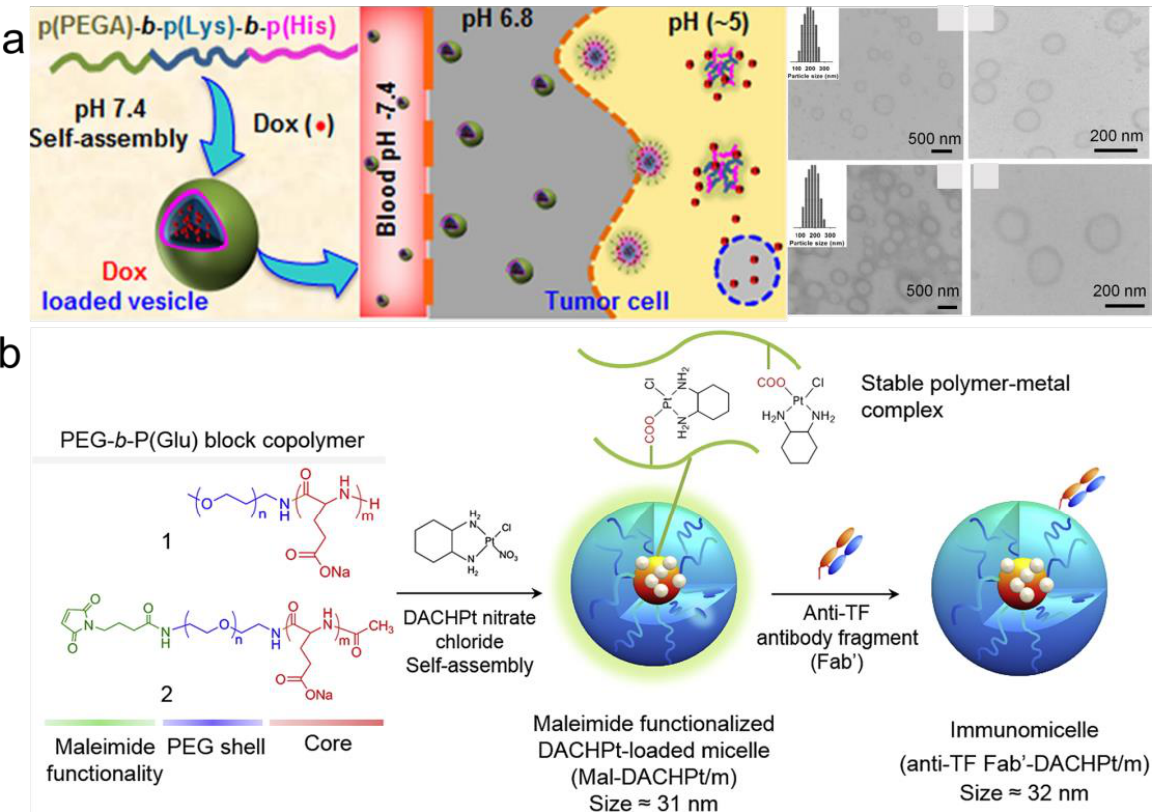
Figure 5. Drug loading in PVs. ( a ) p(PEGA) 30 -b-p(Lys) 25 -b-p(His) n assembled into vesicles with DOX loading. Reprinted with permission from Ref. [74]. Copyright: 2015, American Chemical Society. ( b ) DACHPt loading into PEG-b-PLG copolymers. Reprinted with permission from Ref. [77]. Copyright: 2015, Elsevier.